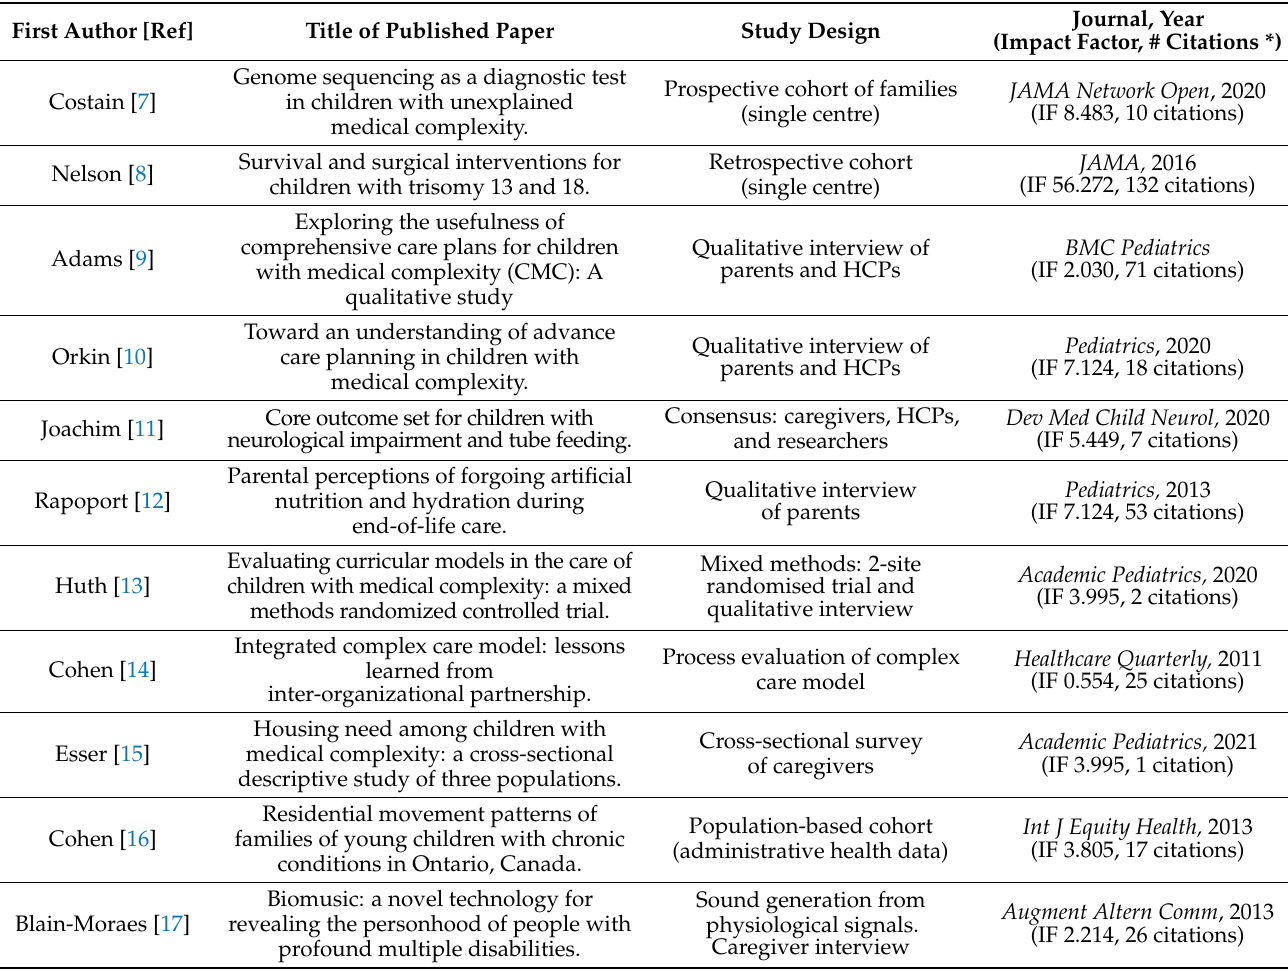
Table 1. Characteristics of selected publications resulting from NSCCI-funded